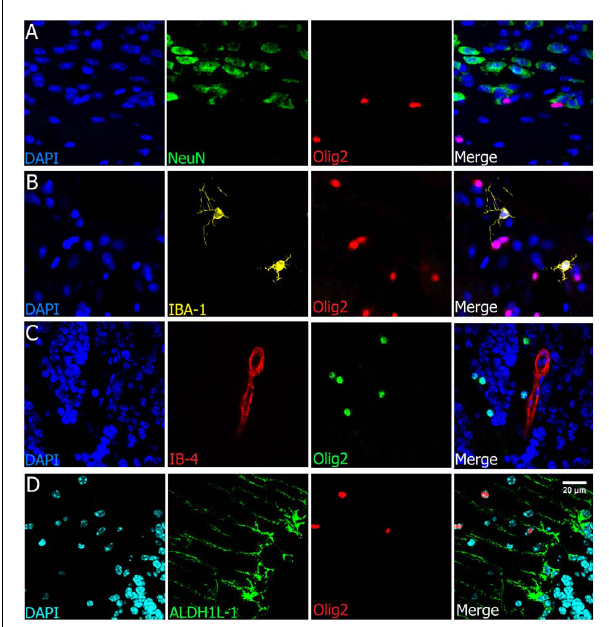
FIGURE 5 | Olig2 is a lineage-specific marker of oligodendrocytes. Double labeling of Olig2 with other major cell types such as neurons ( A , cortex), microglia ( B , cortex), vasculature and endothelial cells ( C , olfactory bulb), and astrocytes ( D , cerebellum), showed no colocalization with those specific cell markers. Scale bar (valid for all photographs): 20 µ m.